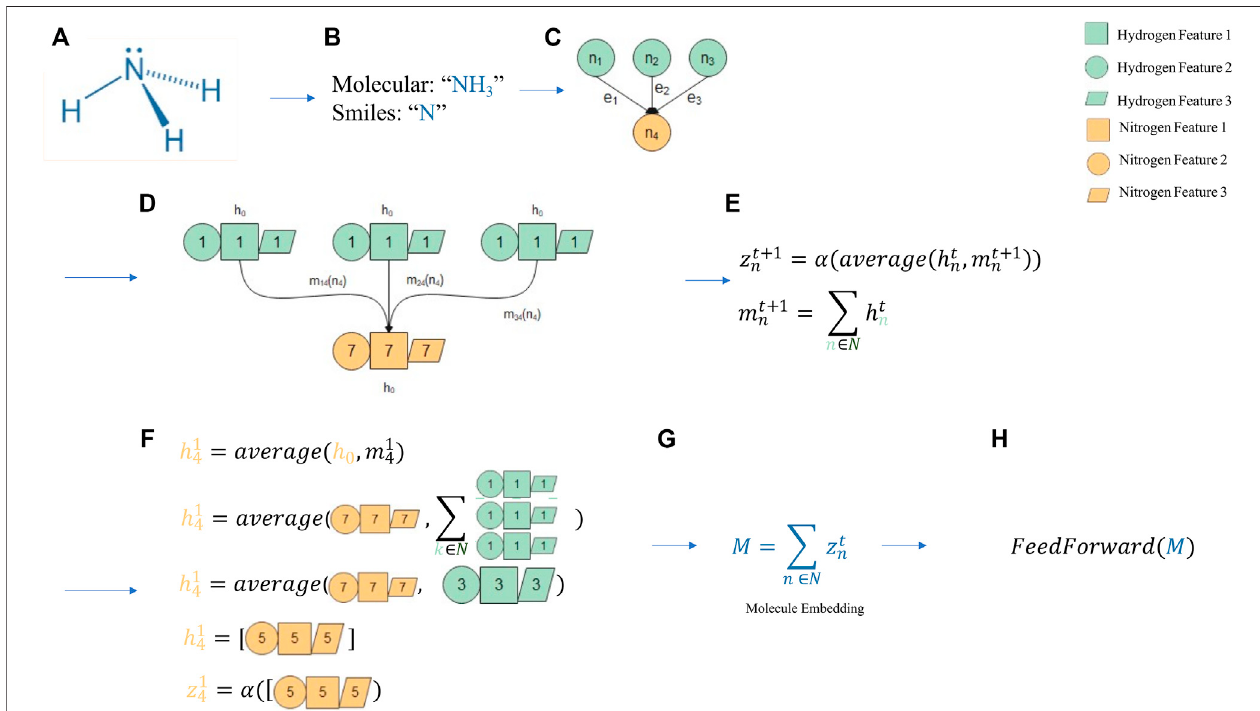
FIGURE 6 | An intuition of a Graph Neural Network. A molecular prediction process scheme employing a message passing neural network (MPNN) as molecule embedder. (A) Ammonia was chosen as a candidate for prediction. (B) Text representation of ammonia as a simpli fi ed molecular-input line-entry system (SMILES) sequence and molecular formula. (C) The SMILES sequences are converted to a graph with three edges representing a molecular bond between hydrogen (green) and nitrogen (yellow). (D) h0 is the feature space for a speci fi c atom, where each feature, herein represented as a geometric form, is didactically associated with the correspondingatomnumber. (E) Thesefeatures comprisetheatomfeatures,whichareaveragedwiththemessagefunction,hereinasasum,ineach stepoftheMPNN training. (F) An example of how the fi rst step of the MPNN is computed for nitrogen (n4) is provided. (G) The fi nal step of MPNN is a feature embedding for each atom, whichcanbesummedtobethenusedbyafeed-forwardnetworkfor fi nalpredictions. (H) Misthefeatureembeddingforeachatom,consistinginashapeof(NAtomsx E Embedding space). This (NxE) tensor can be feeded into a more simplistic network architechture, i.e.: Feed Forward to train task-speci fi c models.